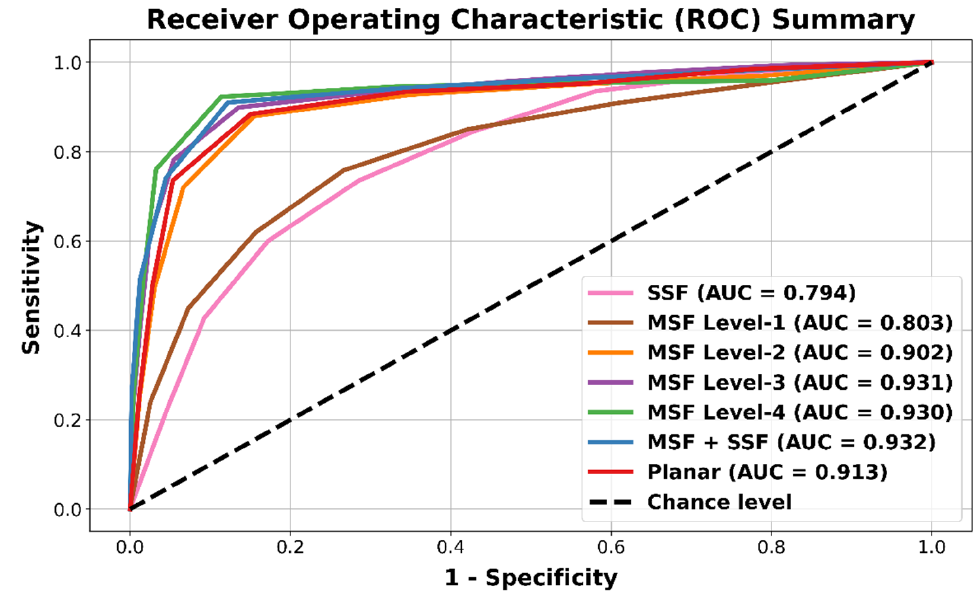
Figure 2. ROC curve summary plot for comparing different SSF, MSF feature groups combination levels (level 1–4), combined MSF + SSF features, and planar features. The MSF level-1, level-2, and level-3 curves are obtained by averaging the performance of different MSF feature combinations in each category. The SSF, MSF level-4, MSF + SSF combined and planar features ROC curves are obtained from specific feature-set based models. The area under the curve (AUC) values are provided in the legend